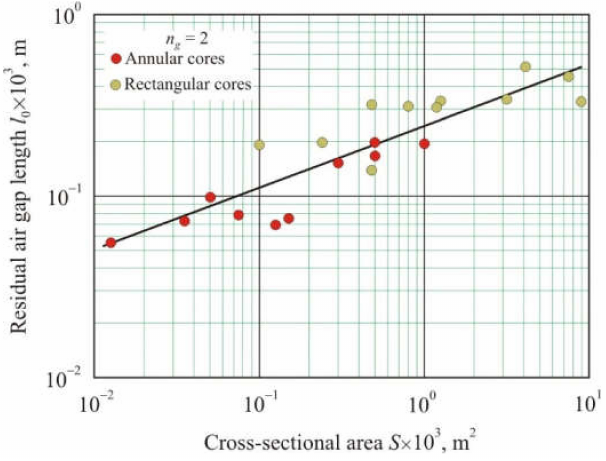
Figure 10. Dependence of the residual air gap length l o on the cross-sectional area S after cutting the nanocrystalline core in half and then tightly compressing the two halves.